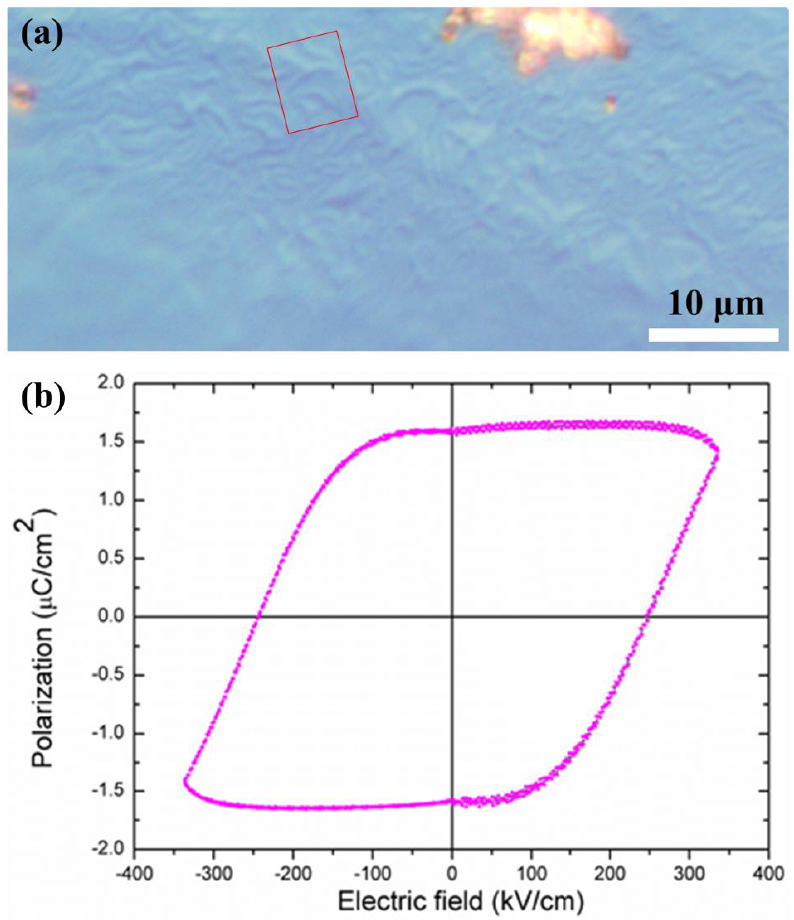
Figure 7. ( a ) Optical microscope image of chemically etched TbInO 3 crystal surface. ( b ) Electric po- larization (P) versus electric field (E) hysteresis loops at room temperature. polarization (P) versus electric field (E) hysteresis loops at room